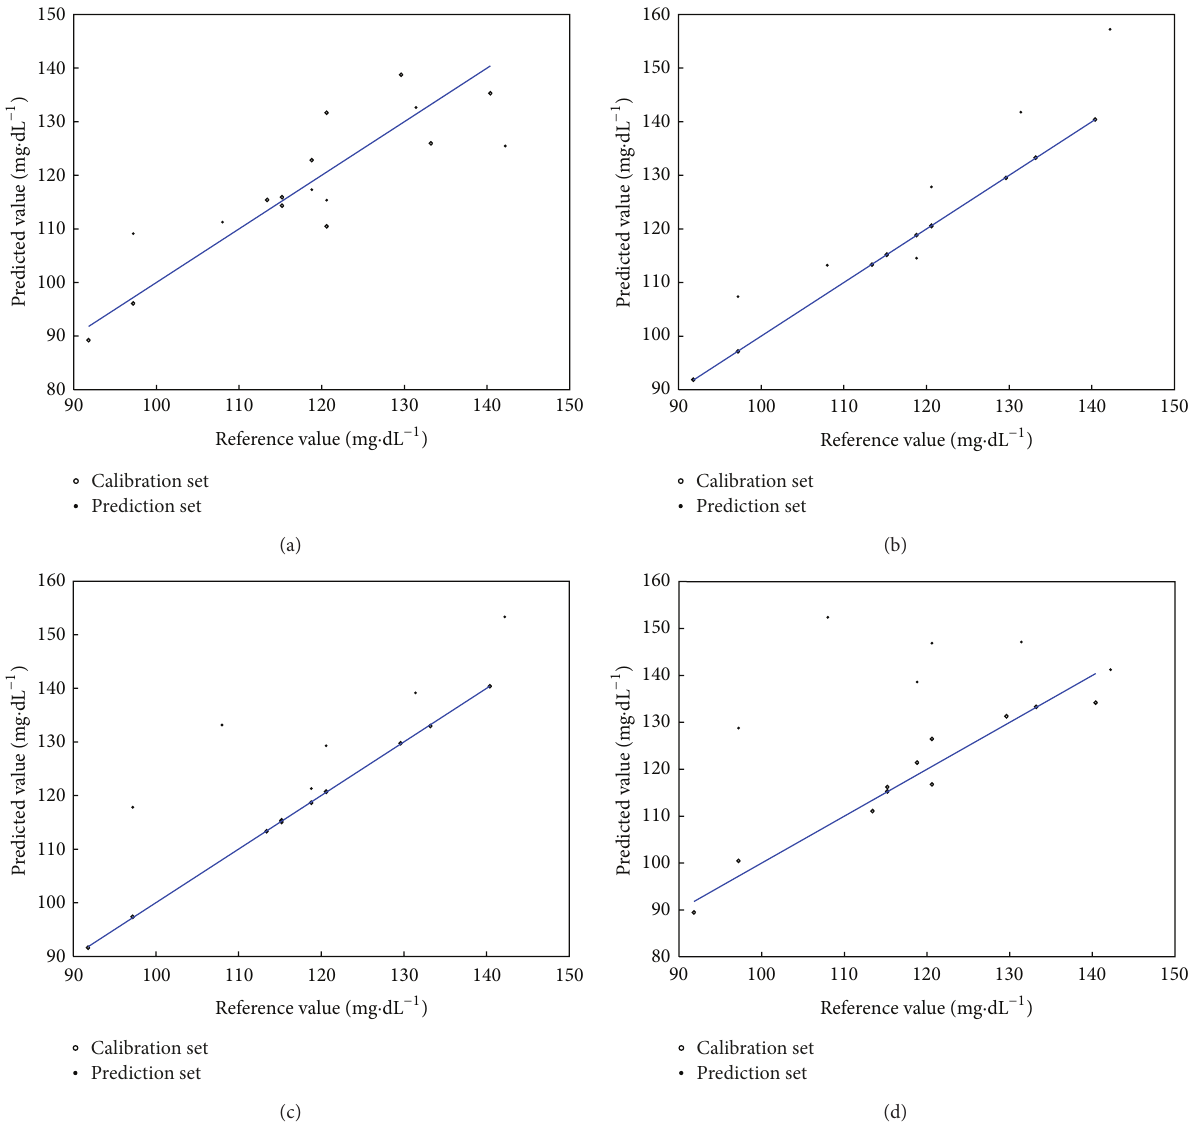
Figure 3: Distribution of predication results with different preprocessing methods. (a) The distribution of predication results of original spectra, (b) the distribution of predication results of the spectra preprocessed by Im-EMSC, (c) the distribution of predication results of the spectra preprocessed by Im-EMSC, and (d) the distribution of predication results of the spectra preprocessed by MSC.